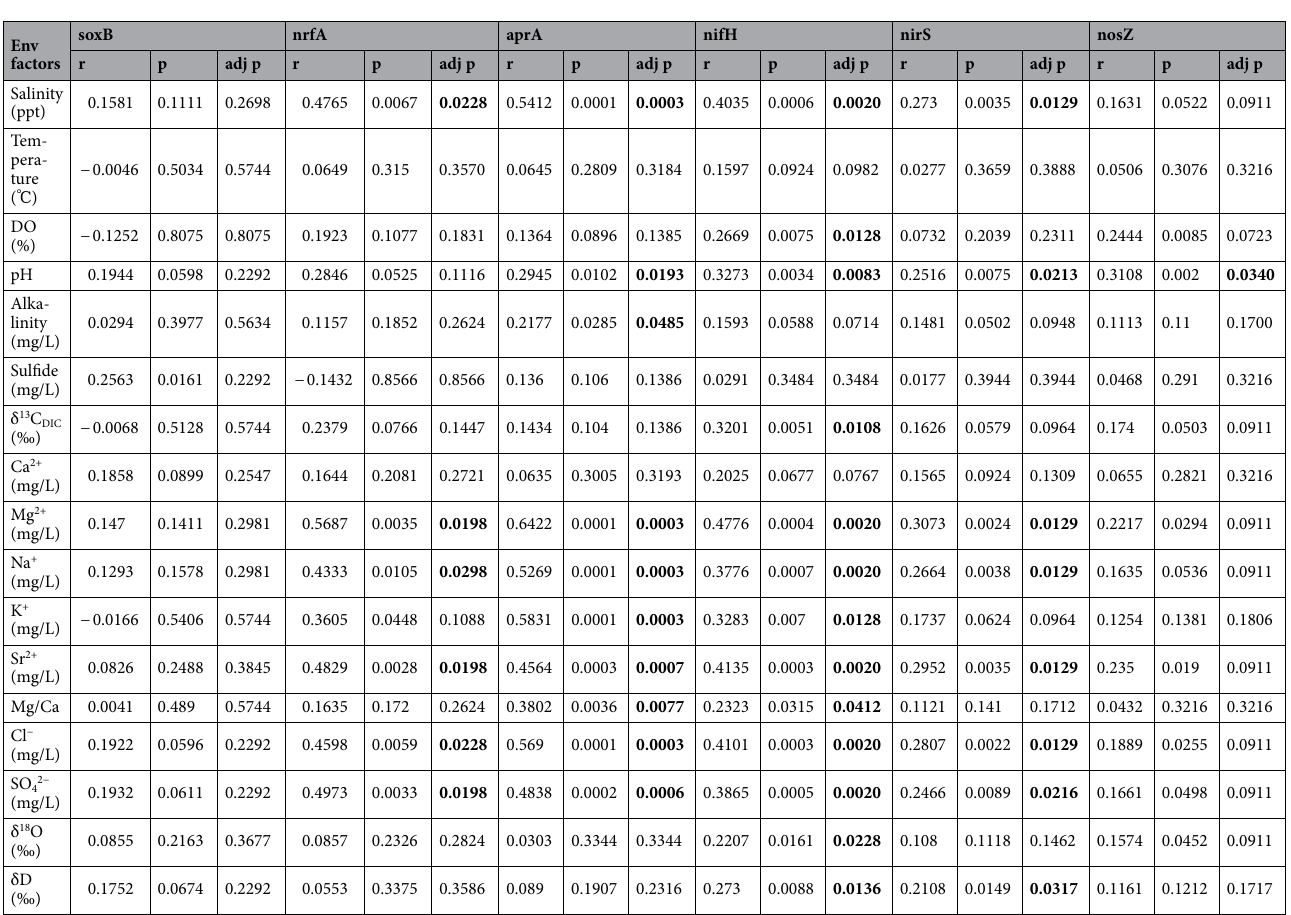
Table 2. Mantel test correlation results of functional genes chosen for downstream analysis with environmental factors (listed in Table S2). Adjusted p-values (adjusted by Bonferroni test, shown in adj p in the table) less than 0.05 are